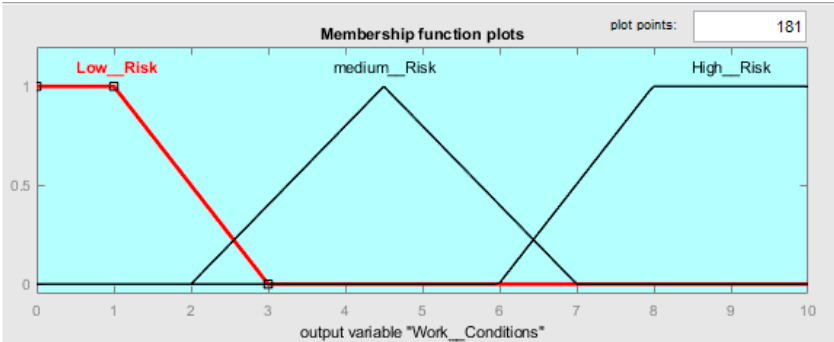
Figure 7. Membership function plots of